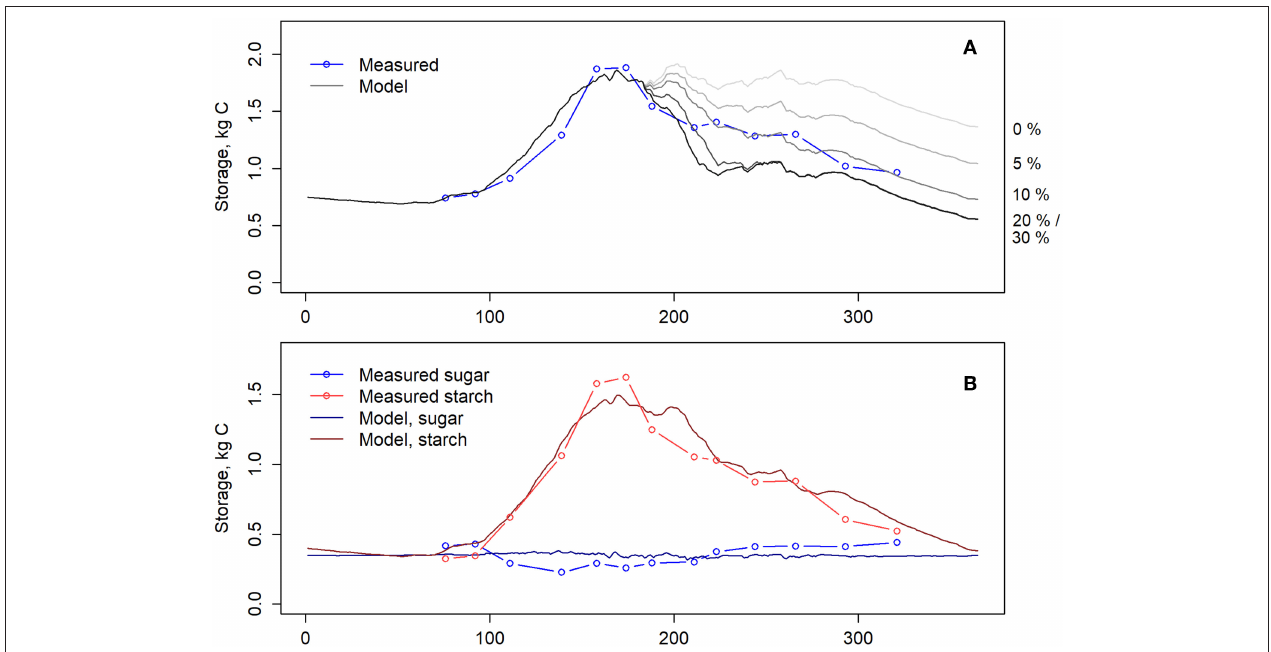
FIGURE 4 | (A) Measured (blue) and modeled (gray) total NSC storage. The model was simulated with various allocation levels to belowground symbionts, via changing parameter a B in equation 9 from 0 to 0.3. The allocation levels of the different simulations are shown on the right side. (B) Measured and modeled soluble sugars and starch. Model simulations were conducted with a B = 0.1. Lines with dots indicate measurements and solid lines model. Blue denotes soluble sugars and red